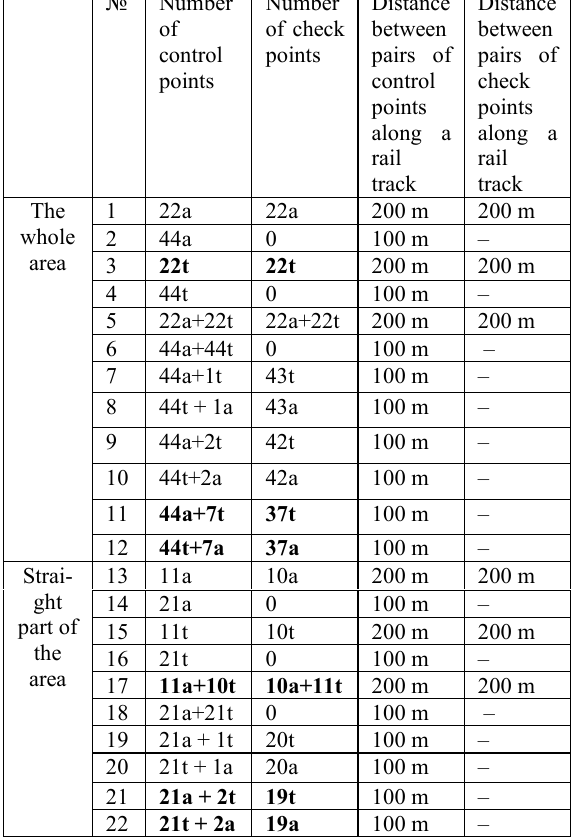
Table 1. The initial data sets used for generation of photogrammetric models